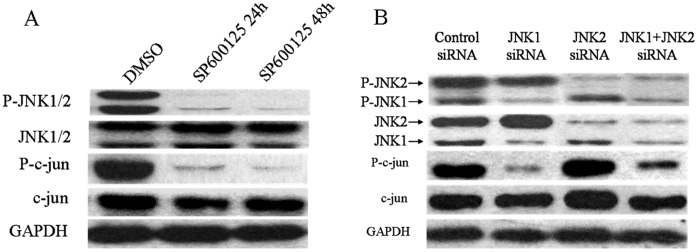
Effects of SP600125, JNK1 and JNK2 siRNA on the inhibition of the JNK/c-jun pathway in SW1116/HCPT cells. A.SW1116/HCPT cells exposed to DMSO and SP600125 at concentrations 20 µM for 24 and 48 hours, with medium replacement every 24 hours. Then expression of phospho-JNK/JNK and phospho-c-jun/c-jun was measured by Western blots. B. SW1116/HCPT cells were transfected with with control siRNA, siRNA JNK1 or siRNA JNK2 for 48 hours, then expression of phospho-JNK/JNK and phospho-c-jun/c-jun protein levels were measured by Western blot.